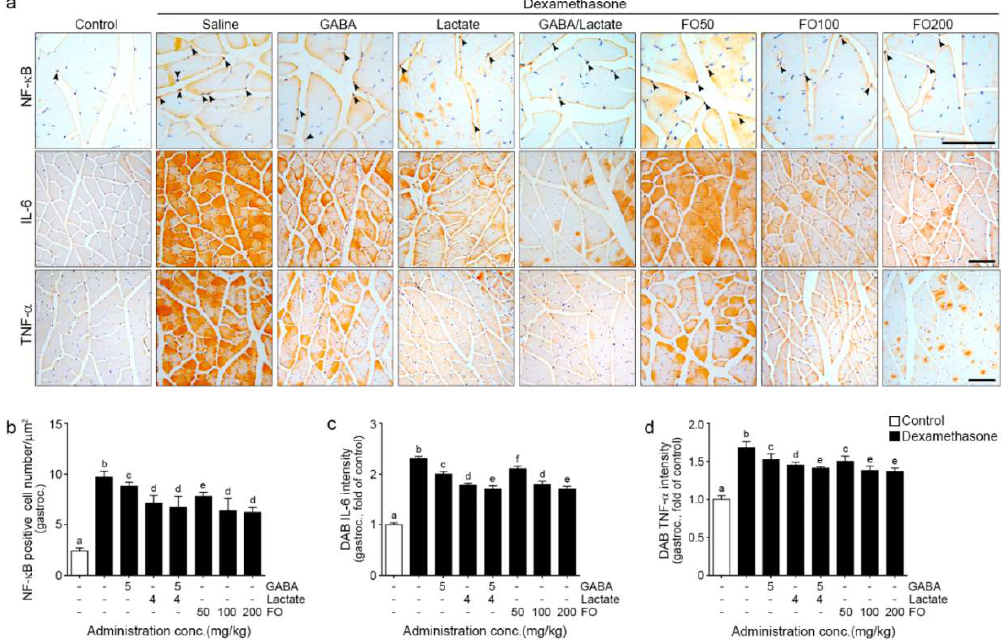
Figure 2. FO reduced intramuscular inflammation in a muscle atrophy-induced mouse model; (( a ) first line and ( b )) The number of NF- κ B translocated into the nucleus was increased Dexa/Saline but decreased by GABA, lactate, GABA+lactate, and FO treatment; (( a ), first and second line, ( c , d )) The intensity of IL-6 and TNF- α were increased Dexa/Saline but decreased by GABA, lactate, GABA+lactate, and FO treatment. Scale bar = 100 µ m. Different letters a–f indicate significant differences among groups as determined by multiple comparisons (Mann-Whitney U test); p < 0.05., 3,3′-Diaminobenzidine tetrahydrochloride (DAB); fermented oyster extracts (FO); γ -aminobutyric acid (GABA); gastrocnemius (gastroc.); interleukin-6 (IL-6); nuclear factor kappa-light-chain-enhancer of activated B cells (NF-κB); tumor necrosis factor-alpha (TNF-α).